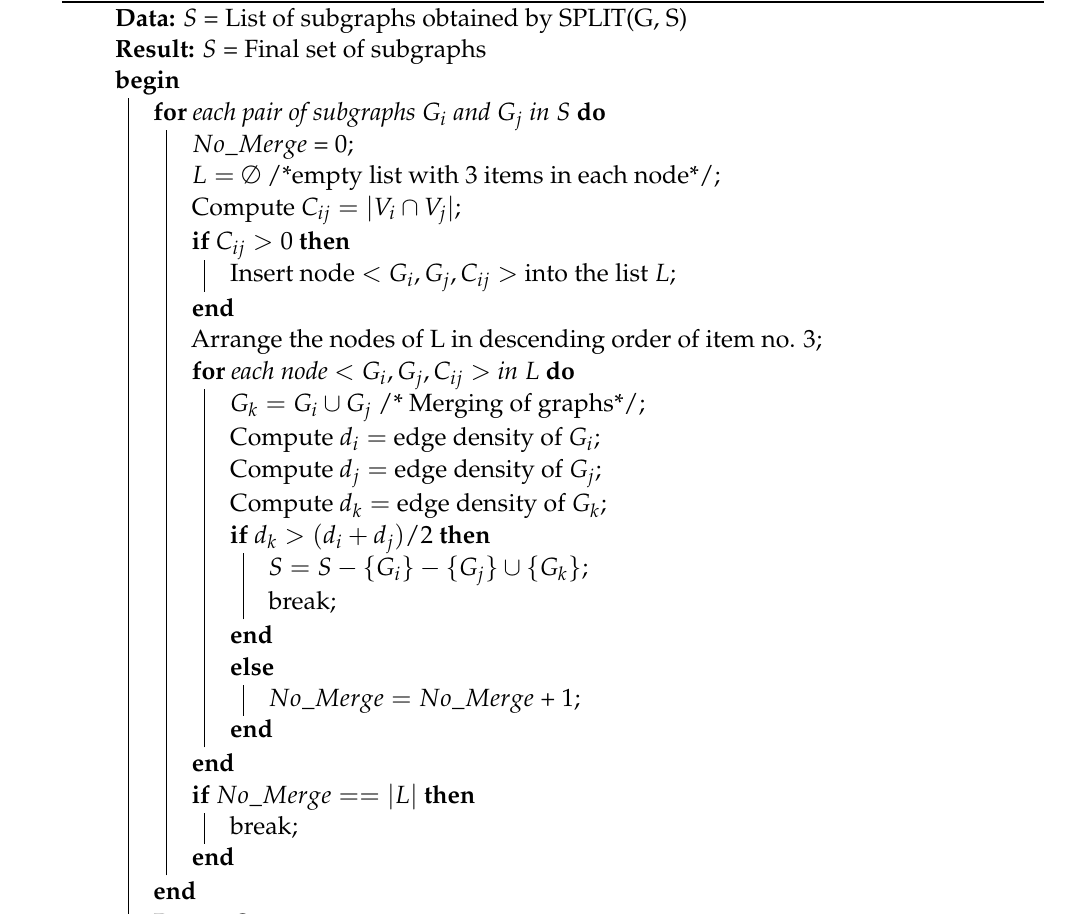
Algorithm 2: Merge subgraphs into graphs- MERGE ( S